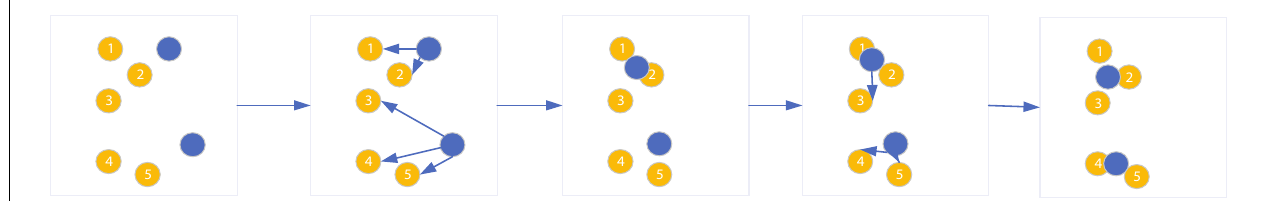
FIGURE 3 | Means clustering analysis